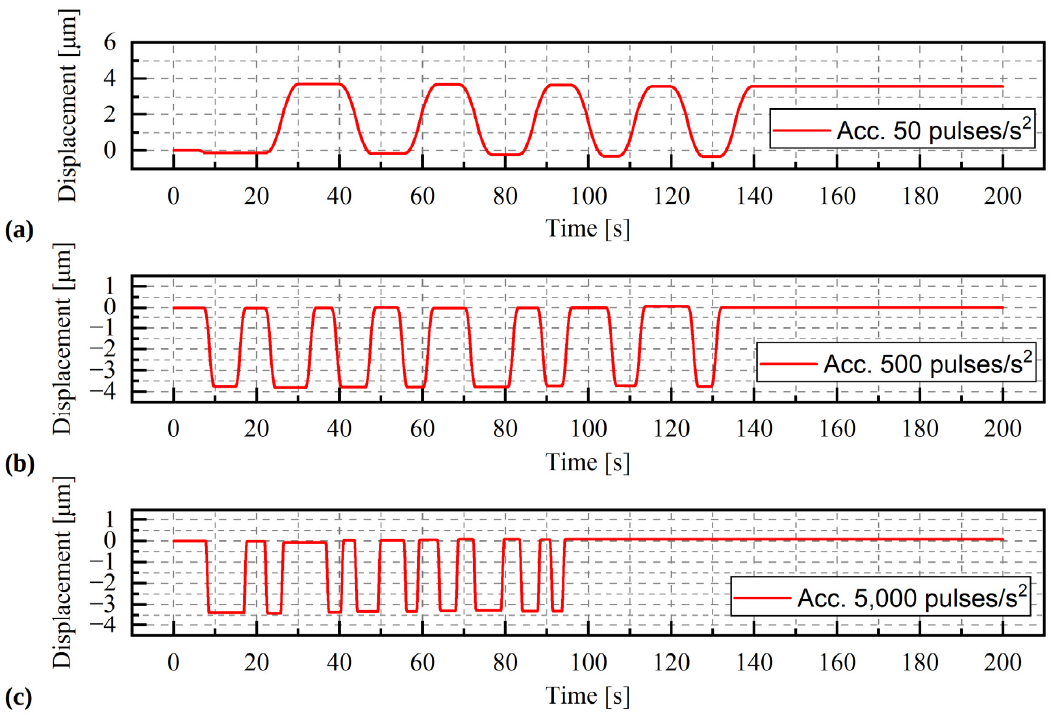
Figure 10. Displacement of the stepper motor with a load of 9.81 N. During the test the acceleration was change ( a ) acceleration = 50 pulses/s 2 , ( b ) acceleration = 500 pulses/s 2 , ( c ) acceleration = 5000 pulses/s 2 .